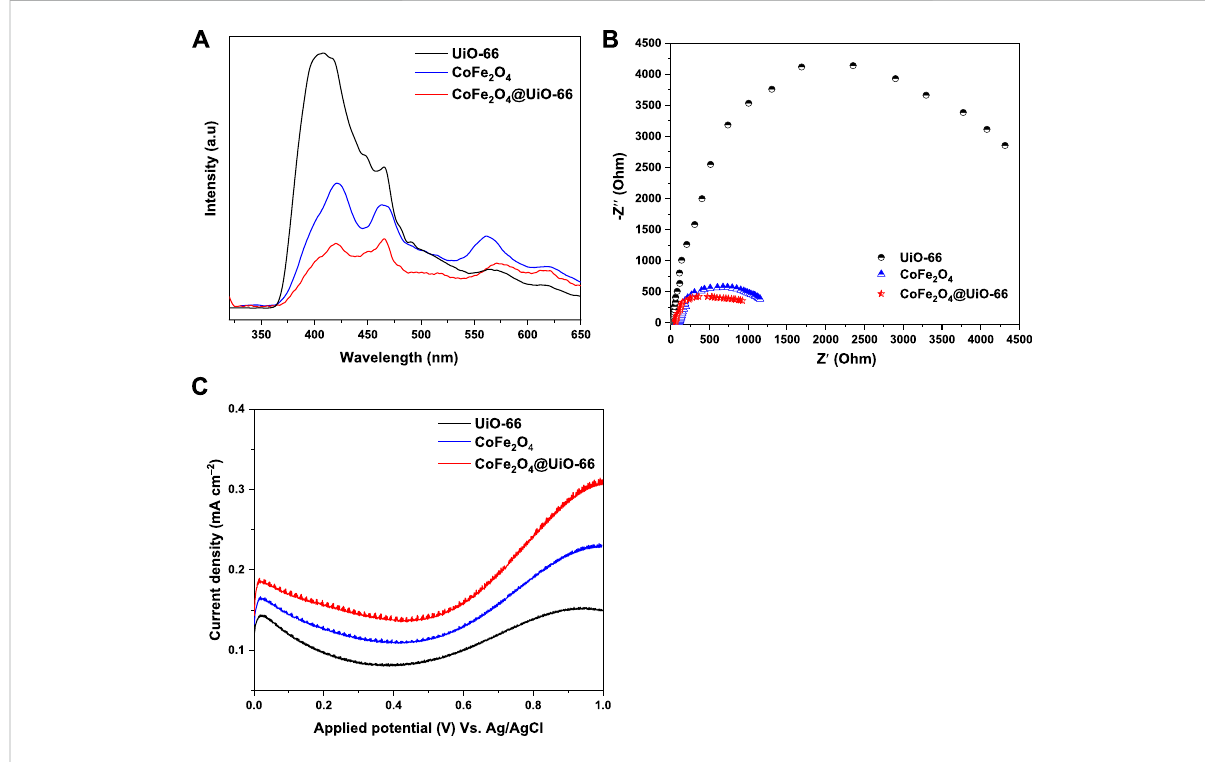
FIGURE 10 PL emission spectra (A) , EIS Nyquist (B) , and LSV curves (C) of UiO-66, CoFe 2 O 4 and CoFe 2 O 4 @UiO-66